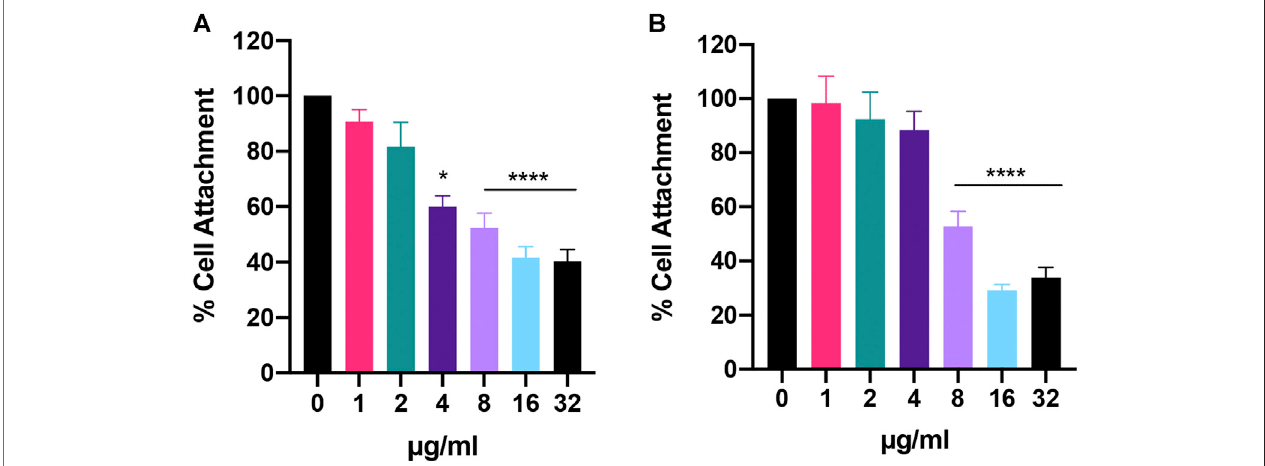
FIGURE 6 | Bay 11-7085 shows anti-bio fi lm activity against C. albicans and C. auris initial cell attachment. (A) C. auris strain #0384 and (B) C. albicans strain SC5314 initial cell attachment was measured using XTT. X-axis represents concentrations of Bay 11-7085 in µg/ml. Statistical signi fi cance was determined using one- way ANOVA with Dunnett ’ s test for multiple comparisons. * p < 0.05; **** p < 0.0001. ( n (cid:2) 3, ± S.D.).